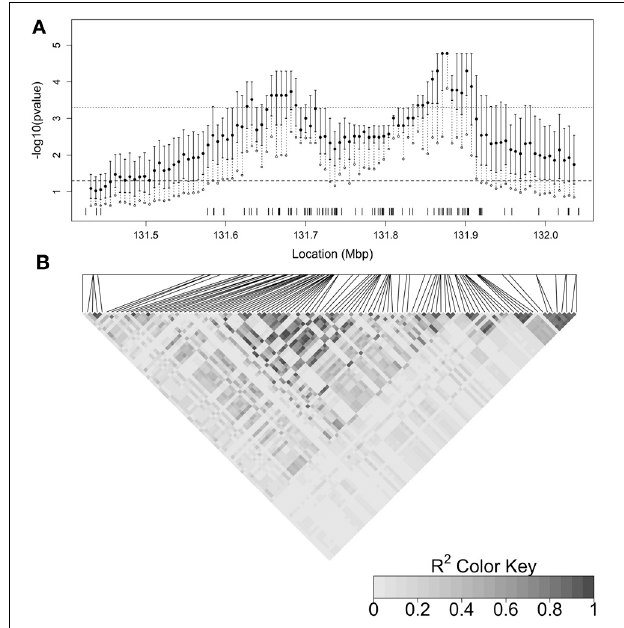
FIGURE 5 | (A) Plot summarizing the distribution of the latent p -values by focal point. The inter-quartile range (IQR) of the latent p -values at each focal point is indicated by the solid vertical line. The filled in circle is the median and the open circle is the 90th percentile of the distribution. The dashed vertical line therefore indicates the range from the 75th to 90th percentile. The dashed horizontal line indicates a p -value cutoff of 0.05 and the dotted horizontal line shows a p -value cutoff of 0.0005 (0.05, Bonferroni-corrected for 100 focal points). SNP locations are marked by tickmarks at the base of the plot. (B) Heatmap of linkage disequilibrium ( R 2 ) between SNPs estimated from control haplotypes and displayed by LDheatmap (Shin et al., 2006). The relative positions of the SNPs are given by the horizontal line above the heatmap and the positions are aligned with (A)